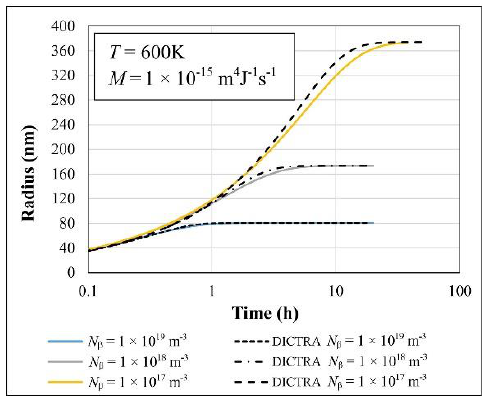
Figure 8. Time evolution of the radius of a spherical θ -Al 2 Cu θ inside a finite Al-1.0 at %Cu matrix at 600 K with three different values for the number density.